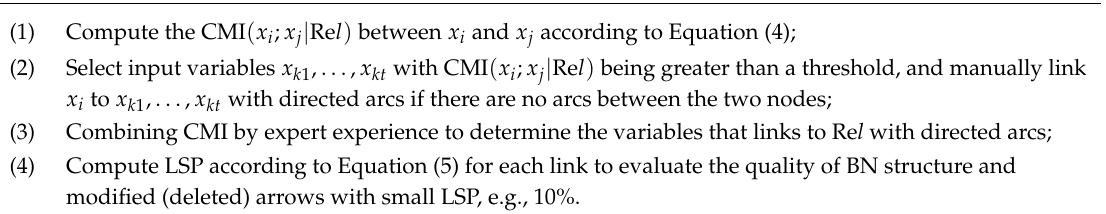
Algorithm 3. Modified BN structure